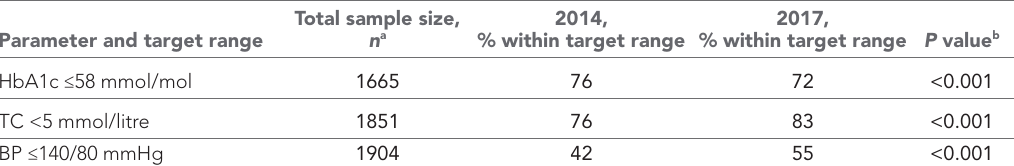
Table 2 Comparison of values of HbA1c, TC, and BP for patients with data recorded for 2014